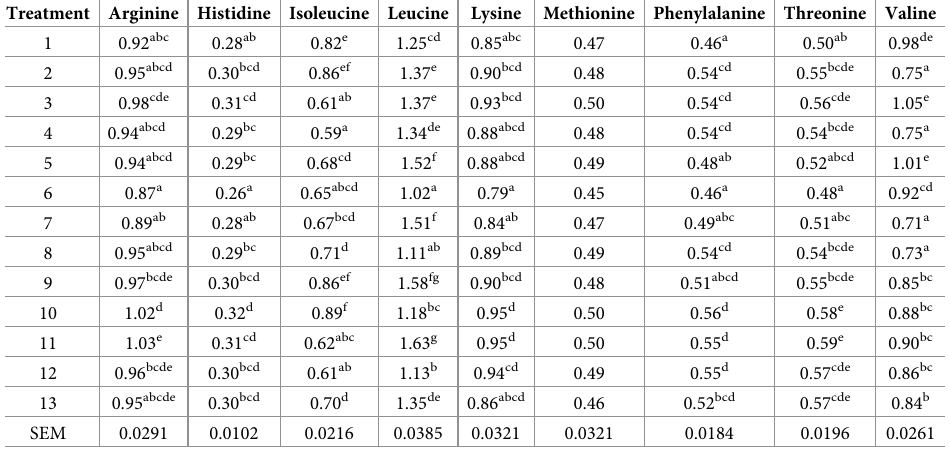
abcdefg Means within columns not sharing a common superscript are significantly different at the 5% level of probability.